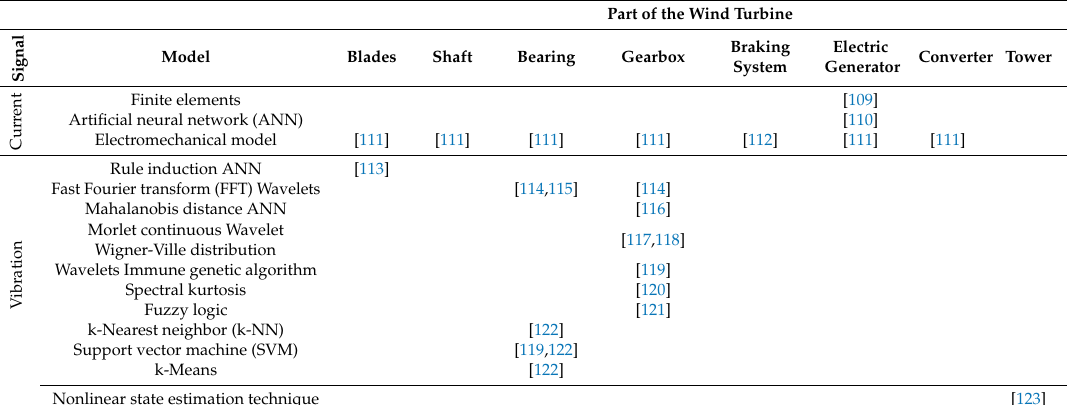
Table 2. References on Applications of mathematical models (MatMs) for Failure Diagnosis in Wind Turbines.